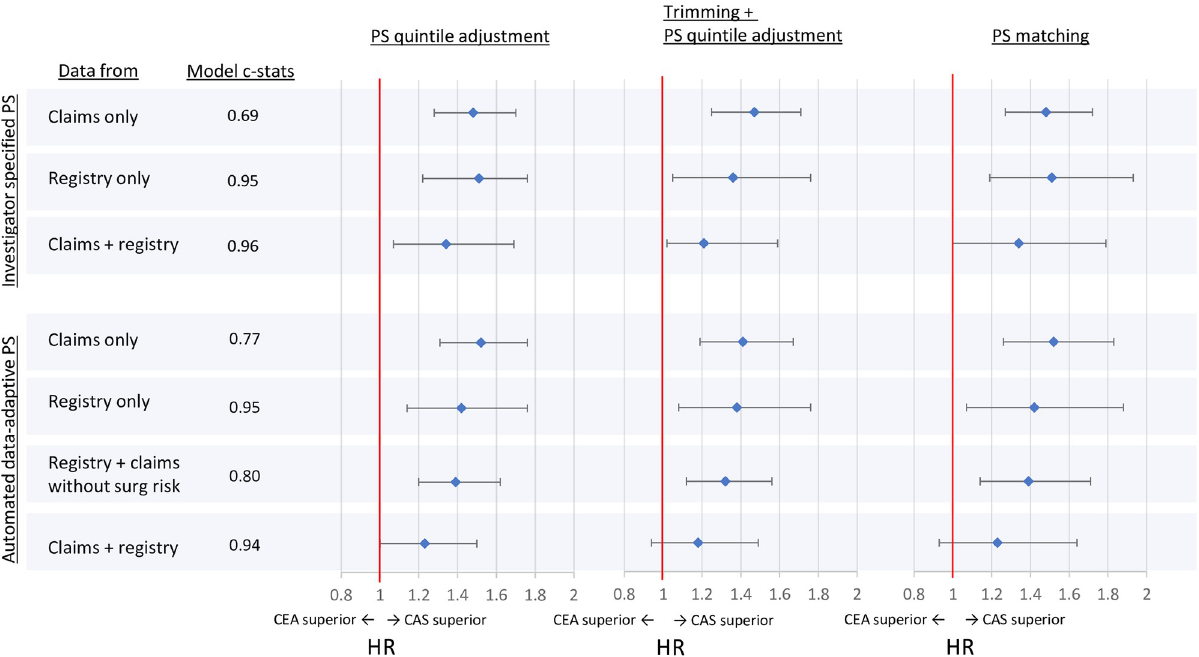
Fig 4. Hazard ratios comparing CAS vs. CEA from outcome models adjusting for investigator specific vs. automated data-adaptive propensity score using covariates from claims only, registry only, or claims+registry. Abbreviations: PS = propensity score, CEA = carotid endoarterectomy, CAS = coronary artery stenting, HR = hazard